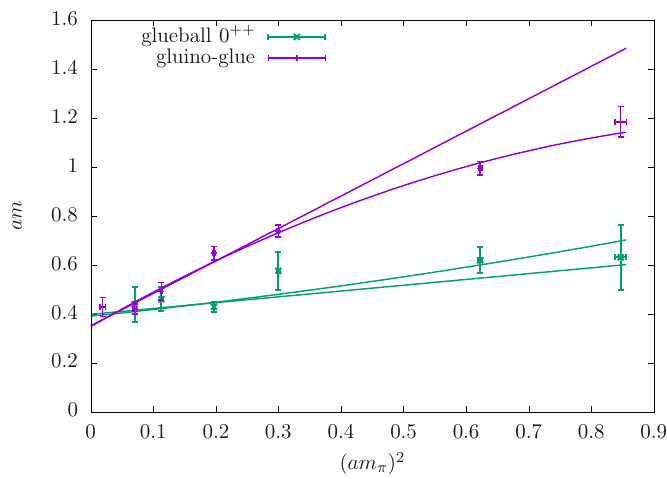
Figure 4. The masses of the gluino-glue and the 0 ++ glueball at β = 5 . 5 in lattice units. The figure shows a linear and a quadratic fit of the data. The two largest values of the adjoint pion mass m π are excluded in the linear fit of the